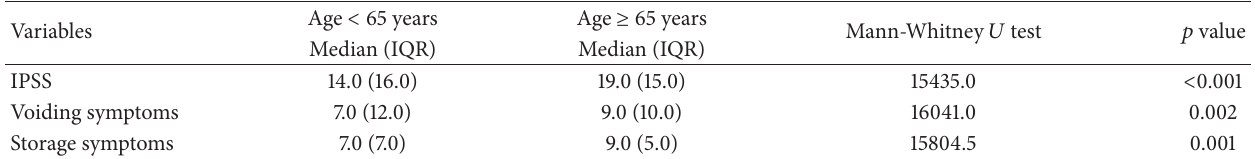
Table 2: IPSS, voiding, and storage subscores among the age group.